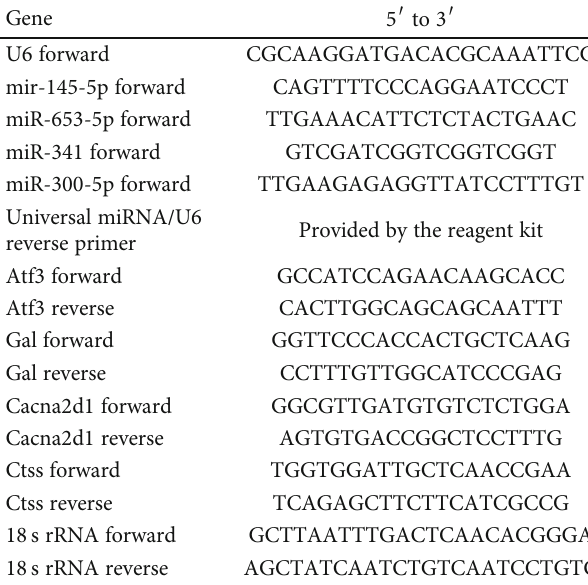
Table 1: The primers used in qRT-PCR.